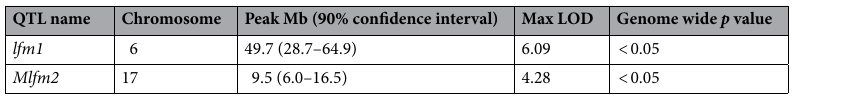
Table 1. Macrophage lysosome function modifier